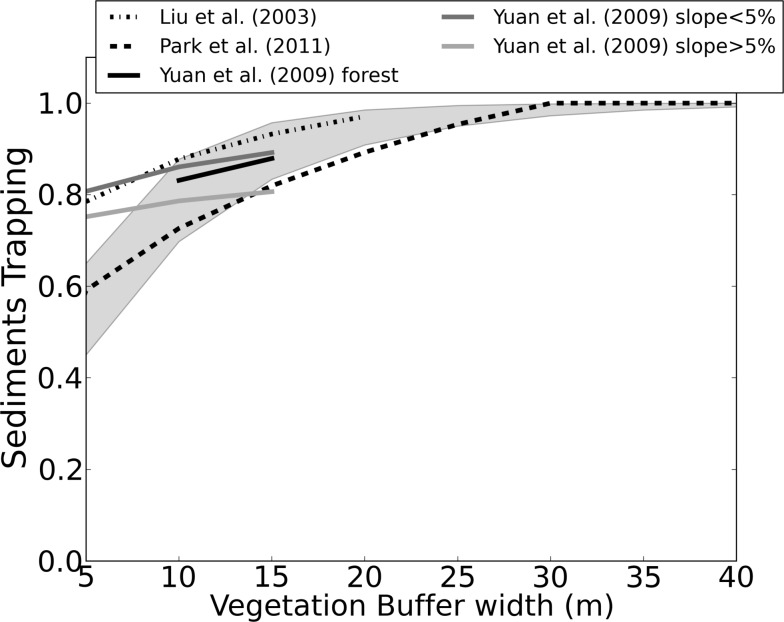
Relationship between sediments trapping and vegetation buffer width suggested by Liu et al., Park et al., and Yuan et al. [42–44], and for the Sediment Retention Efficiency of InVEST between 45% and 65% (in shaded).